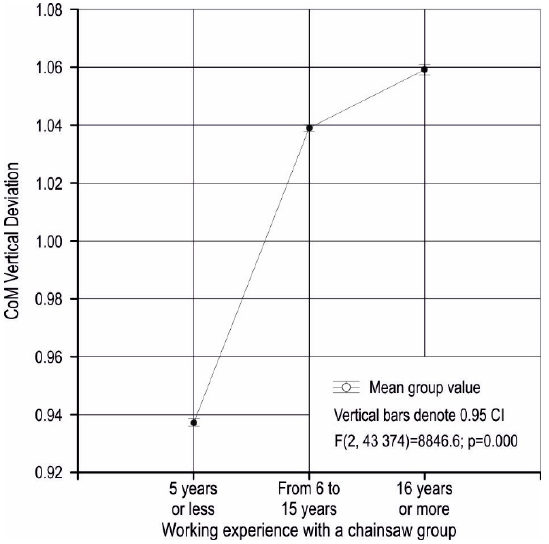
Figure 4. The CoM vertical deviation (m) versus Working experience with a chainsaw.